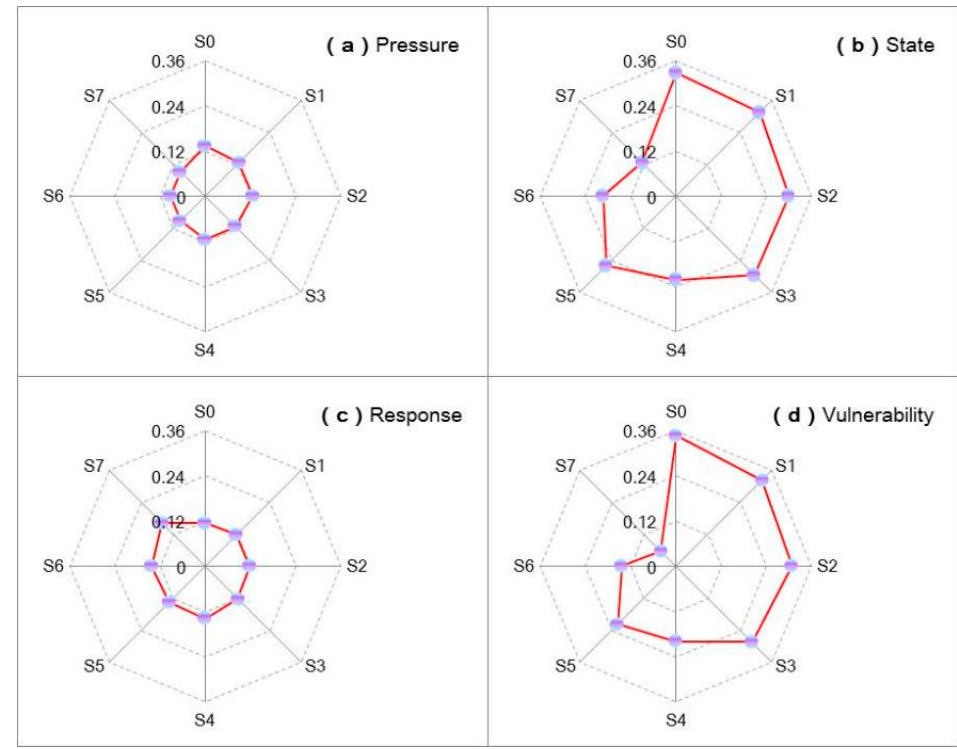
Figure 8. The vulnerability of resources (WEF) under S0 to S7. (( a – c ) are the measure of vulnerability based on Driver–Pressure–State–Response (DPSR) Model; ( d ) is the total vulnerability level)